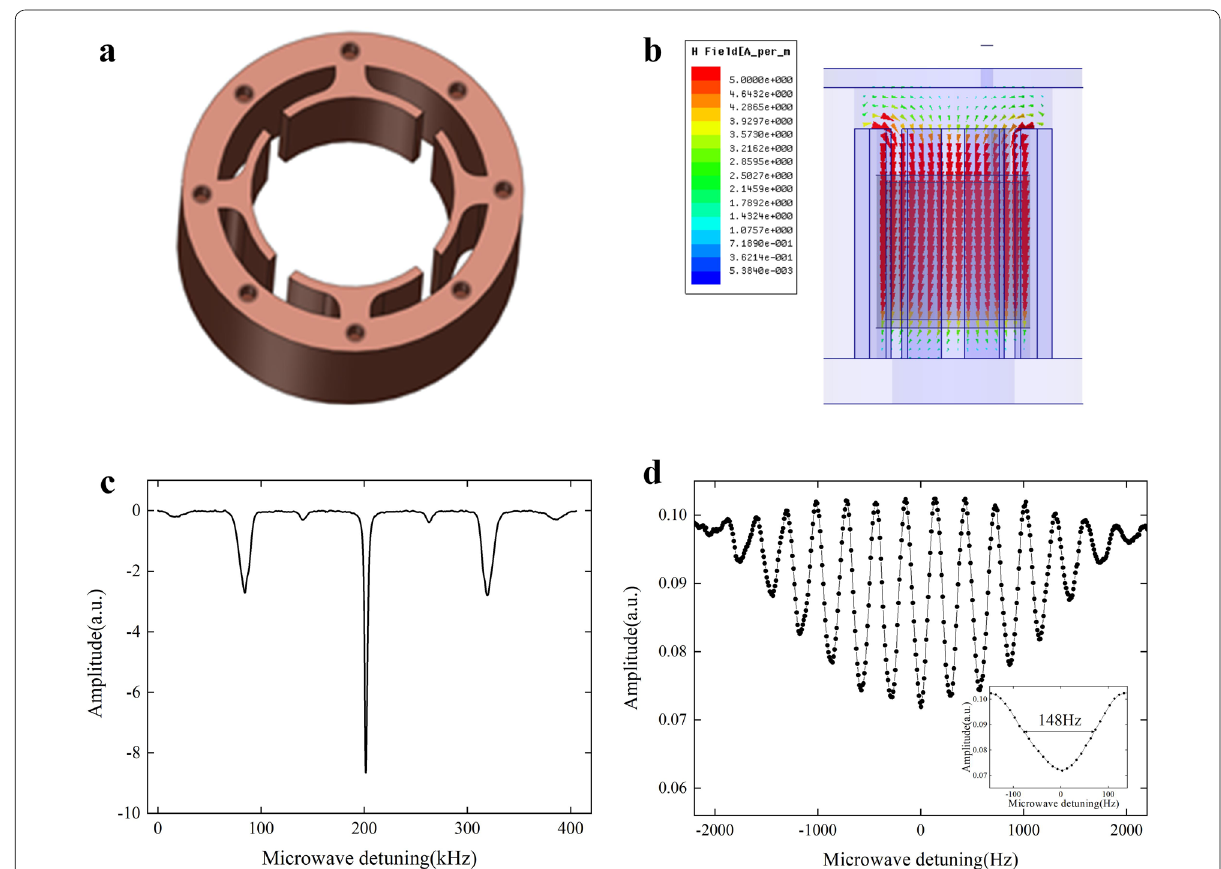
Fig. 2 a Structure of the magnetron-type cavity, b Simulated result of the microwave magnetic field with a glass cell inside, c Zeeman transition strengths between the hyperfine levels F 1 and F 2 of 87 Rb ground state, d The observed Ramsey fringe. The sequence of the Ramsey = = interrogation is set as follows: pumping pulse duration T p